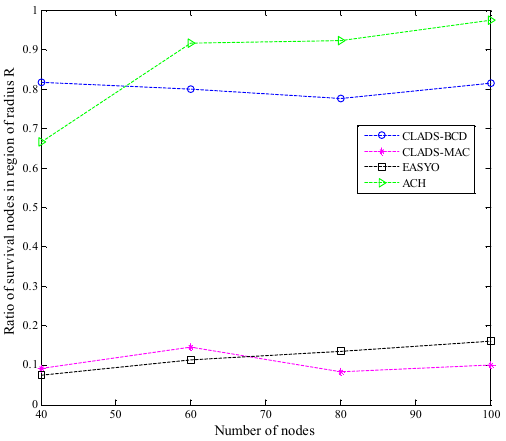
Figure 3. Comparison of the ratio of survival nodes in the region of radius R.